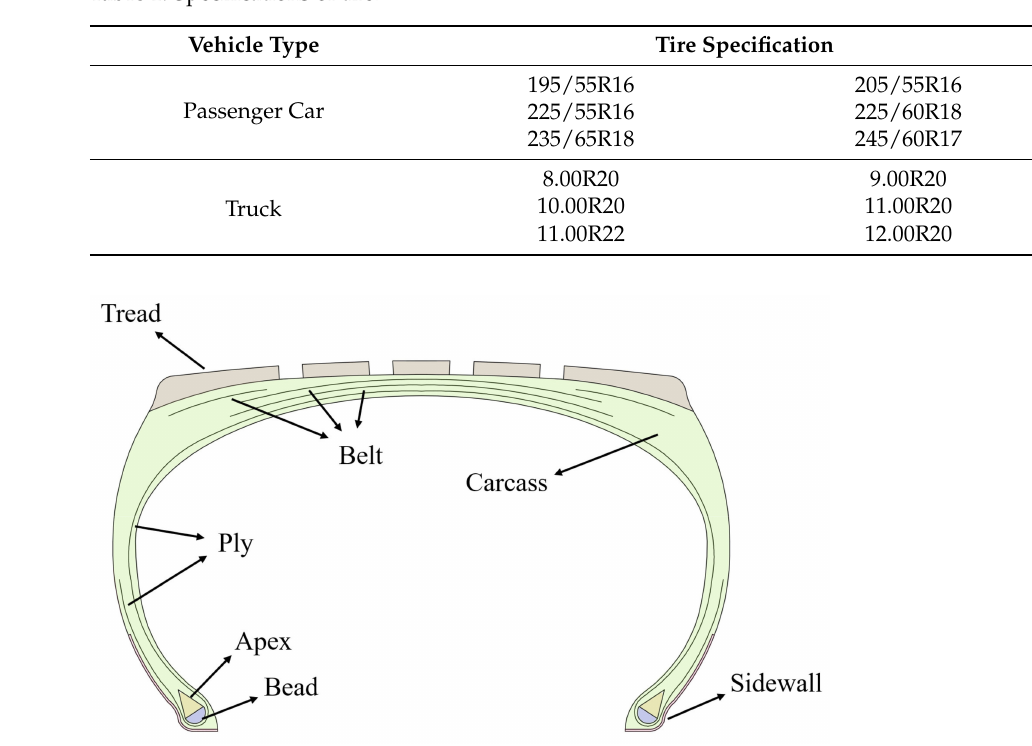
Figure 4. Tire identification: ( a ) passenger car tire; ( b ) truck tire. Table 1. Specifications of tire.